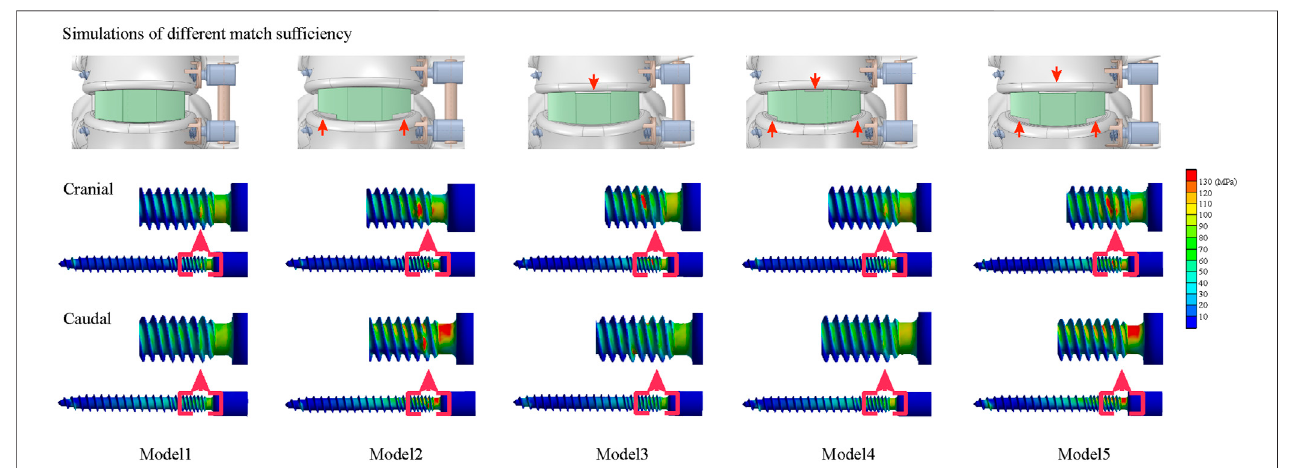
FIGURE 5 | Different match suf fi ciency and nephograms of